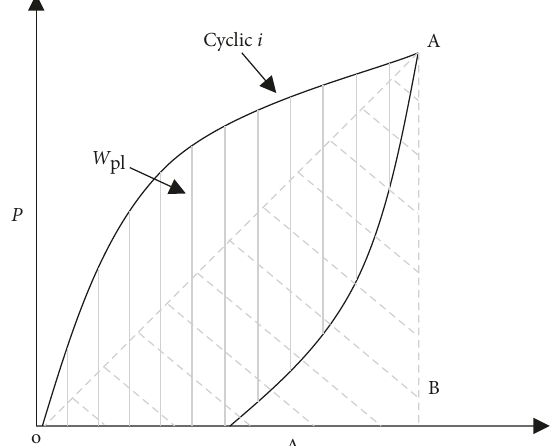
Figure 10: Definition of the dissipated energy W